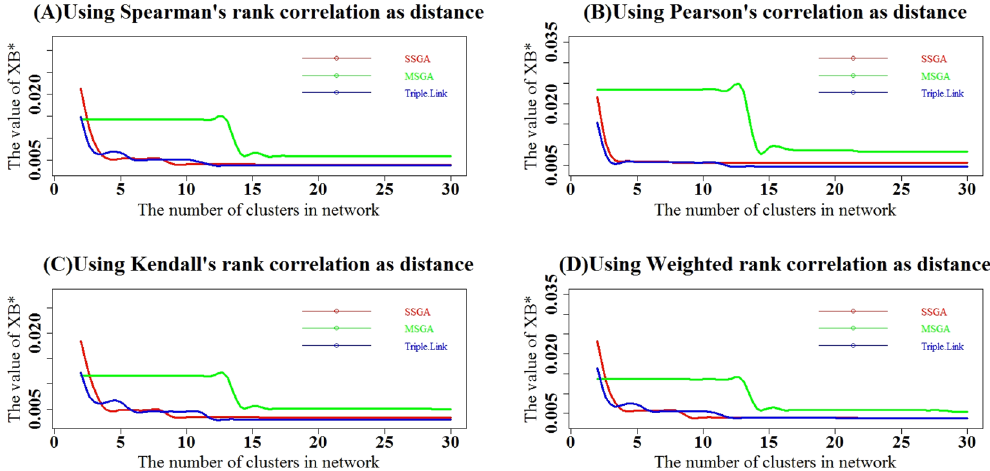
Figure 9. Comparison of subnetworks derived from SSGA, MSGA and Triple-Link Algorithm with XE * indices. The XE * indices of top i subnetworks derived from SSGA, MSGA and Triple-Link Algorithm where i = (2, … , 29, 30). The XE * indices were calculated with Spearman rank correlation coefficients as distances ( A ), Pearson product-moment correlation ( B ), Kendall’s rank correlation ( C ) and Weighted rank correlation ( D ). In all the cases, a higher XE * index represents a greater degree of coordination in the top i